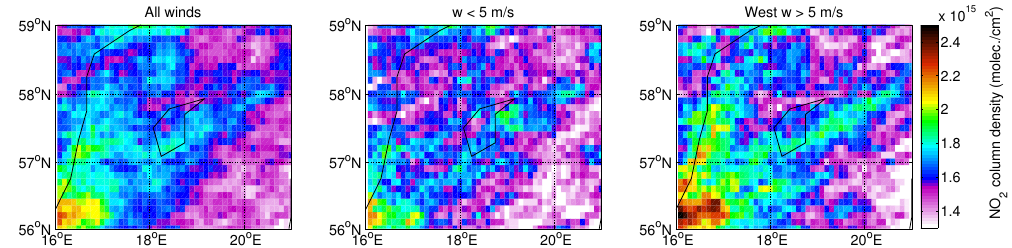
Figure 5. Summer 2005–2011 mean tropospheric NO 2 columns in the Baltic Sea for all wind conditions (first panel), weak winds, i.e. w < 5ms − 1 (central panel) and westerly winds with w > 5m s − 1 (right panel).